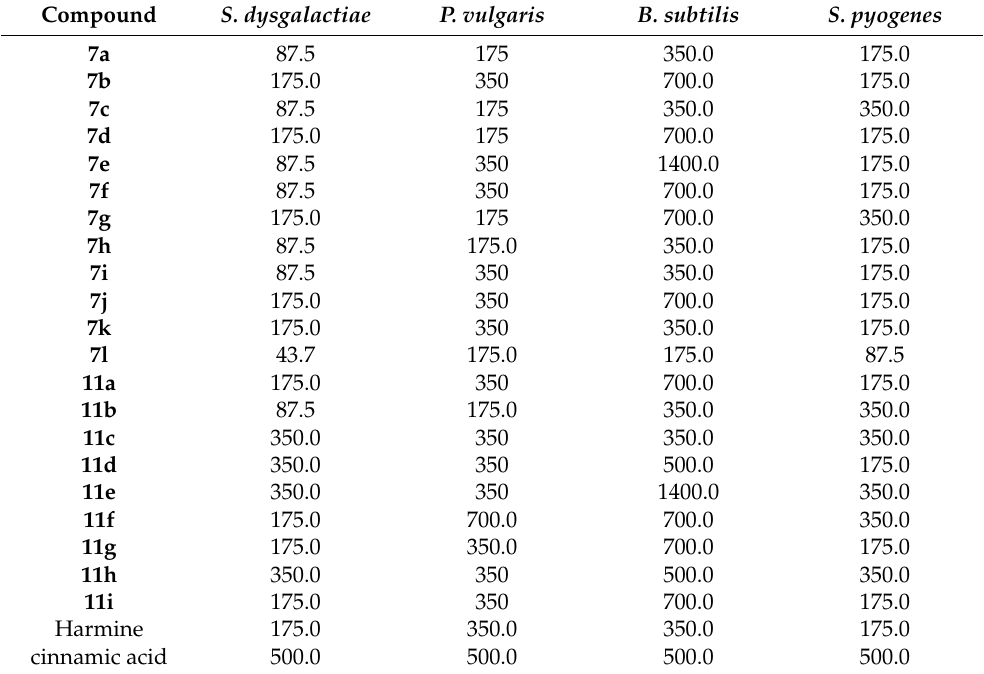
Table 1. Minimum Inhibitory Concentration (MICs) (μg·mL −1 ).